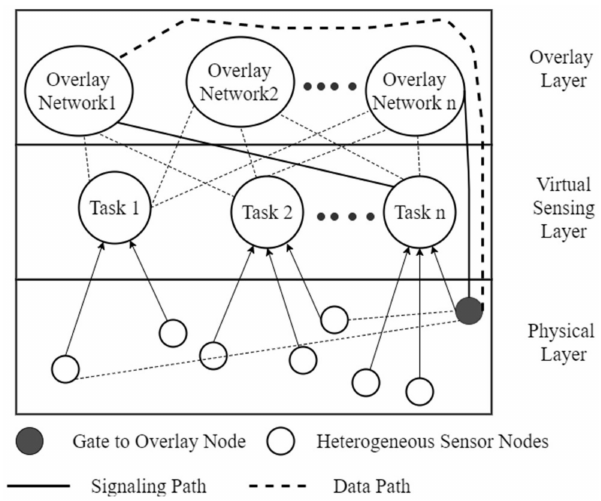
Figure 7. Gate to overheard virtualization